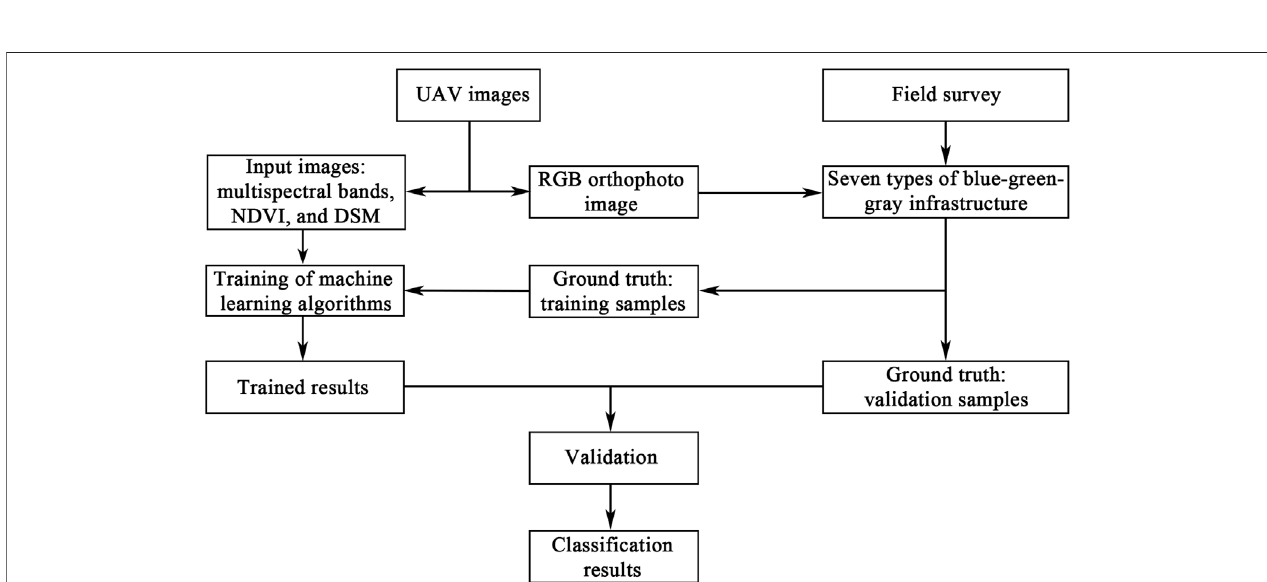
FIGURE 2 | Methodology for blue-green-gray infrastructure classi fi cation from UAV data.